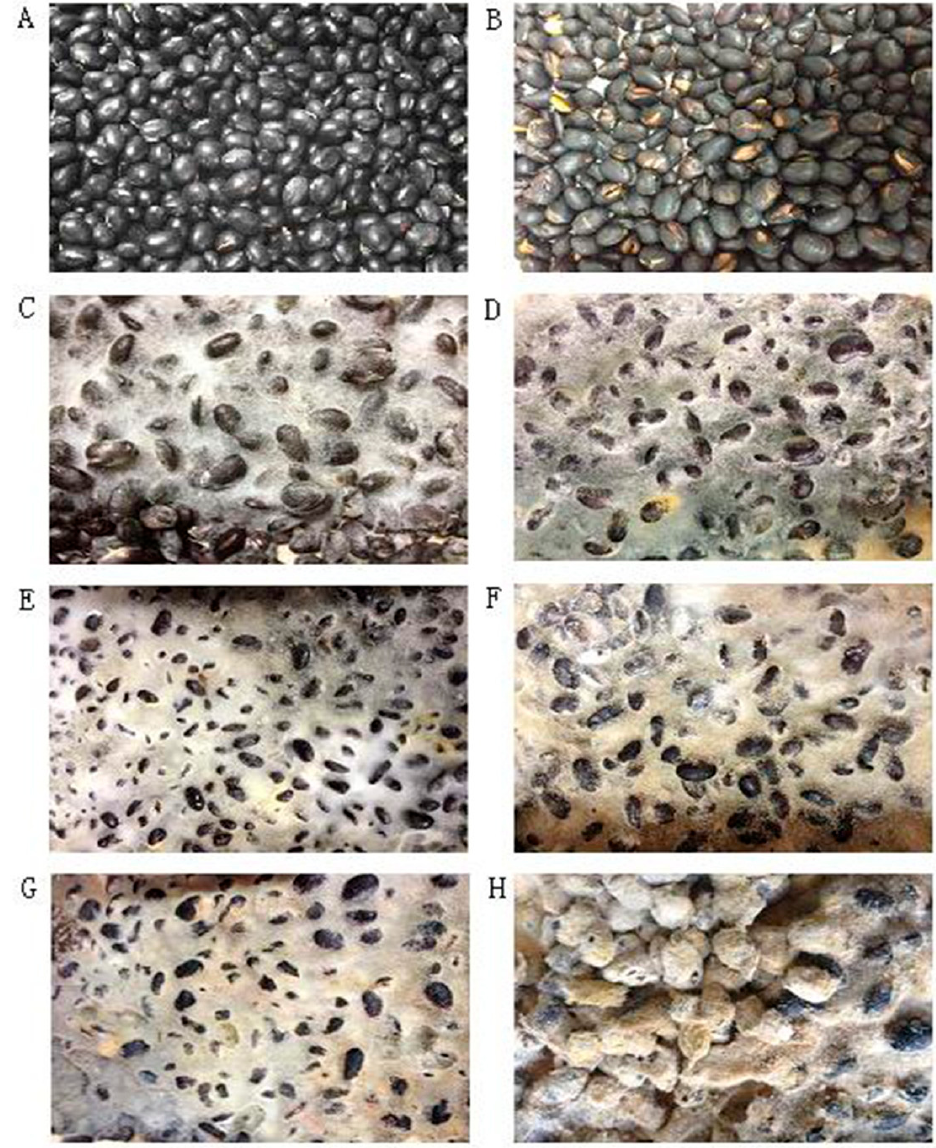
Figure 1. The morphology of soybean ( A ), S0 ( B ), S2 ( C ), S4 ( D ), S6 ( E ), S8 ( F ), S10 ( G ), S15 ( H ) days.